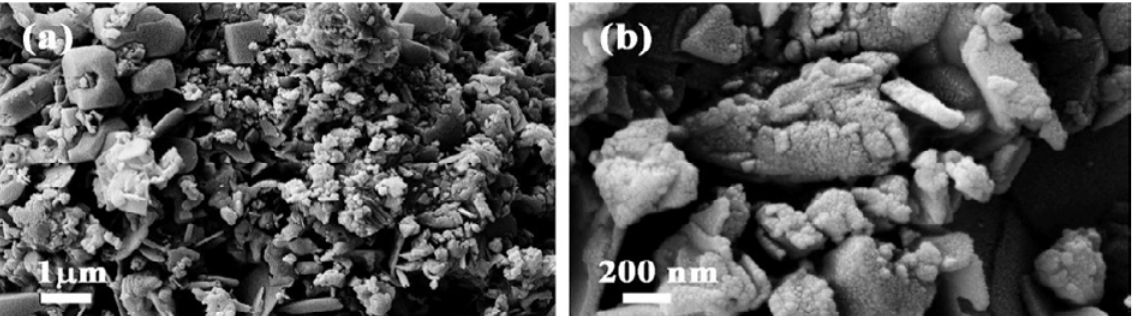
Figure 1. FESEM images of Fe-Co-V/Zeolite at different scales (a, b)